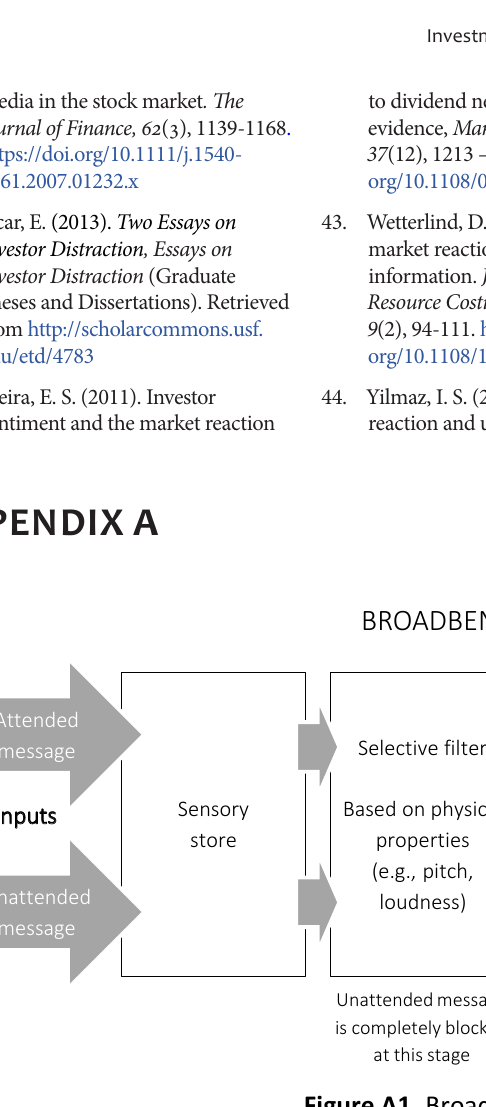
Figure A1. Broadbent’s filter model Table A1. Empirical literature and tools used on investors reaction to news in various markets